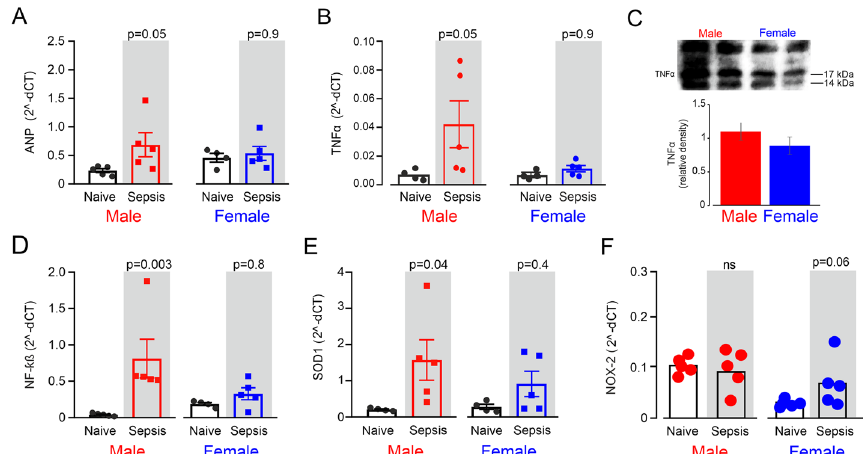
Fig. 4 Messenger RNA signatures of cardiac injury/inflammation after polymicrobial sepsis. A mRNA expression in left ventricle of atrial natriuretic peptide (ANP). Wild-type male mice ( n 5) showed higher = ANP gene transcription relative to naive sex and age-matched naïve males 18 h after the onset of sepsis and compared to age-matched females ( n 5). B Cardiac inflammation as indicated by mRNA expression of TNFα = in left ventricle. Only male wild-type mice ( n 5) showed higher TNFα gene transcription 18 h after the onset = of sepsis, compared to age-matched females ( n 5). C Semi-quantitative analysis by immunoblotting for = cardiac TNFα in four mice/group. D Cardiac inflammation as indicated by mRNA expression of NF-kappa B in left ventricle. Only male wild-type mice ( n 5) showed higher NF-kappa B gene transcription 18 h after the = onset of sepsis, compared to age-matched females ( n 5). E Cardiac oxidative stress as indicated by mRNA = expression of Superoxide dismutase-1 in left ventricle. Only male wild-type mice ( n 5) showed higher = SOD-1 gene transcription 18 h after the onset of sepsis, compared to age-matched females ( n 5). F mRNA = expression of nicotinamide adenine dinucleotide phosphate oxidase 2 (NADPH oxidase 2 or Nox2) in left ventricle. ( n 5/group). Individual p values on each panel refer to post hoc testing after ANOVA testing for = genotype x sepsis